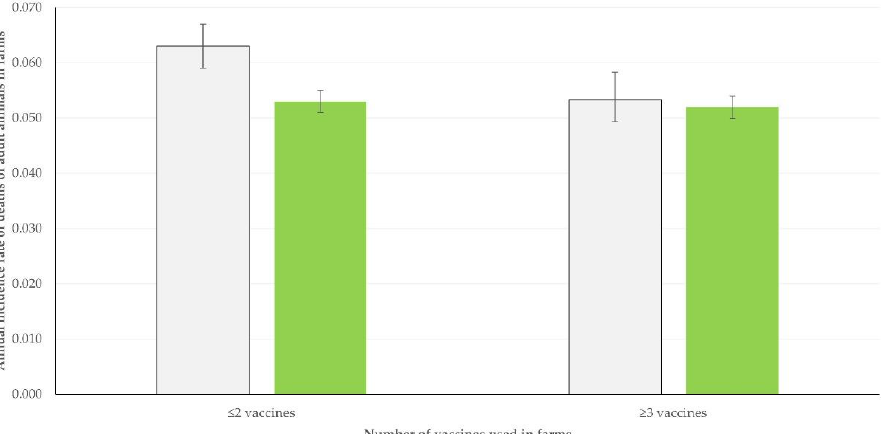
Figure 5. Incidence rate of mortality of adult animals in sheep flocks (green) or goat herds (grey) in Greece, in accord with the total number of vaccines against infections that might lead in death of